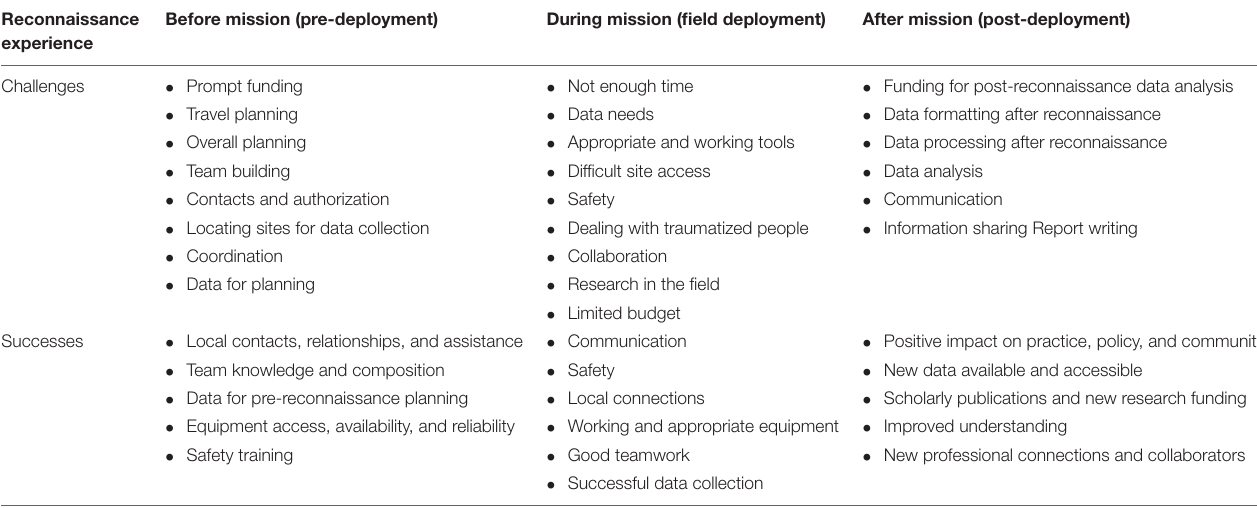
TABLE 2 | Synthesis of key themes in workshop participant responses to questions about challenges and successes before, during, and after reconnaissance missions (see Supplementary Material for complete list).